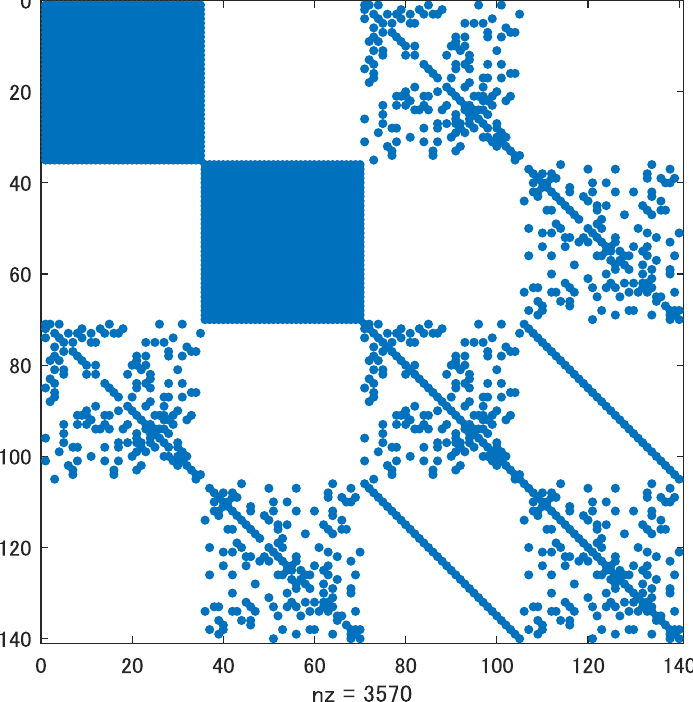
Figure 4. Sparsity pattern of the coefficient matrix after the 2nd elimination for